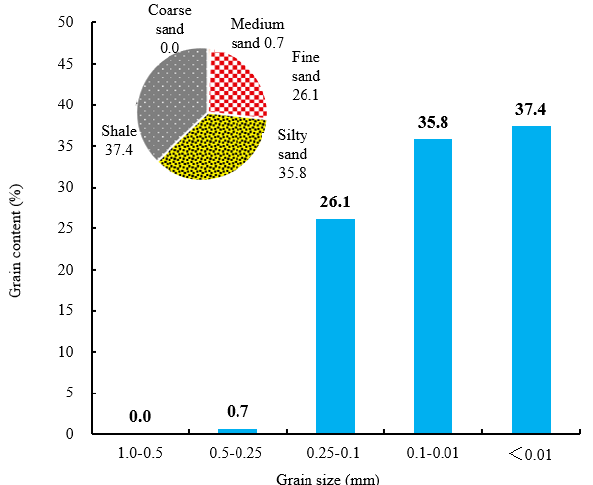
Energies 2022 , 15 , x FOR PEER REVIEW Figure 1. Grain size analysis of P Formation in Kalamkas Oilfield . Figure 1. Grain size analysis of P Formation in Kalamkas Oilfield.